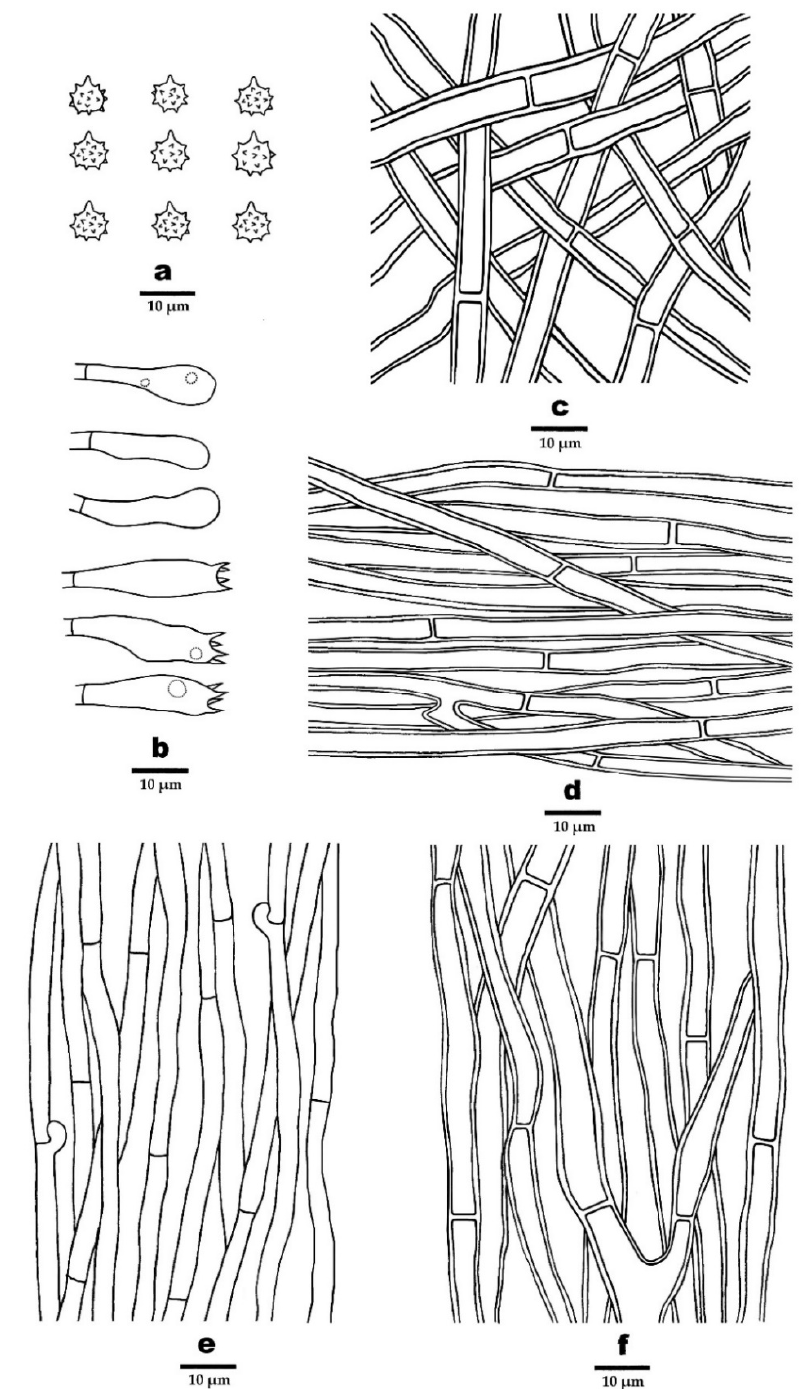
Figure 7. Microscopic structures of P. perchocolatus (drawn from the holotype). ( a ) Basidiospores, ( b ) Basidia and basidioles, ( c ). Hyphae from pileal surface, ( d ) Hyphae from context, ( e ) Hyphae from spines, and ( f ) Hyphae from stipe.